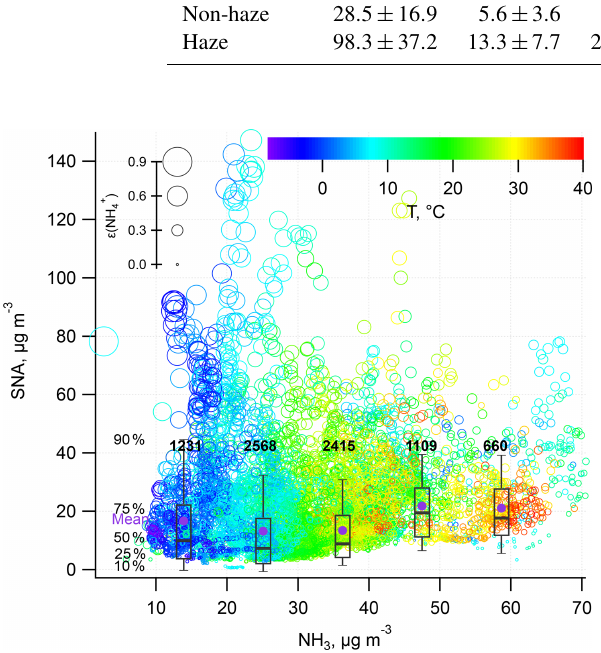
Figure 4. Secondary inorganic aerosol mass concentration in PM 2 . 5 (SNA refers to sulfate, nitrate, and ammonium) as a function of NH 3 . The sizes of the void circles are scaled to the ε (NH + colored according to T . The number of data points in each NH 3 concentration bin is also shown.